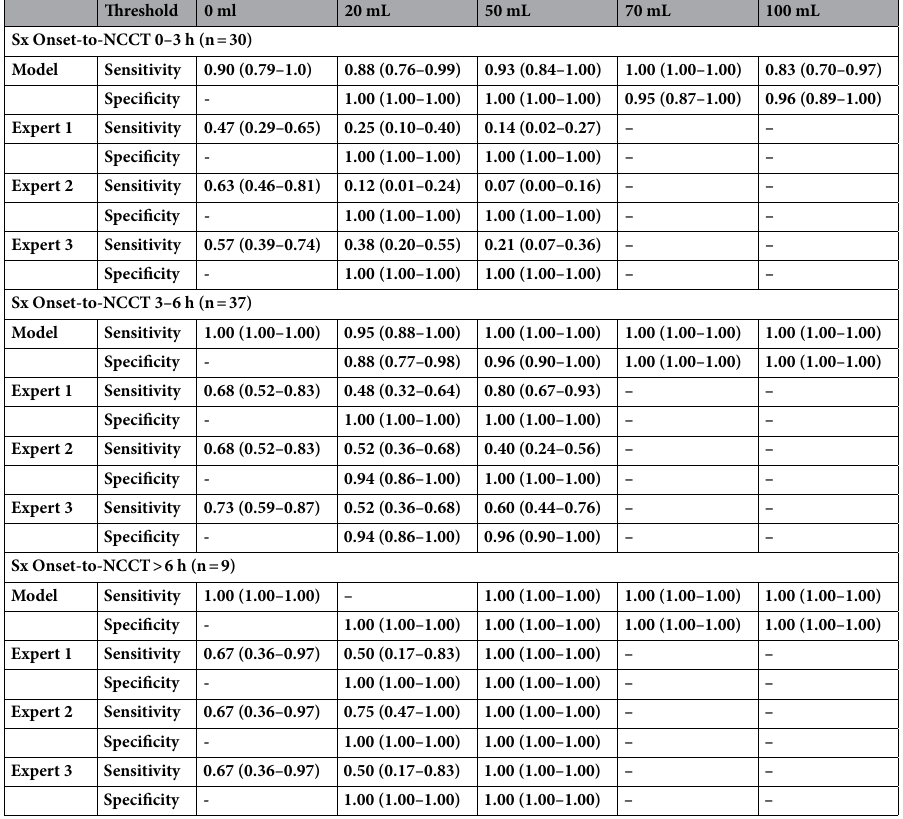
Table 2. Model and expert reader sensitivities and specificities of Fig. 2b, stratified by 0-3 h, 3-6 h, and > 6 h symptom (sx) onset-to-NCCT times, in the “MCA-territory only” test set ( a-c , calculated at the model’s 0 mL-threshold for infarct detection, for the n = 76 patients for whom onset-to-NCCT time data was available). Overall onset-to-NCCT times ranged from 32 min to 22.9 h, median 3.7 h.